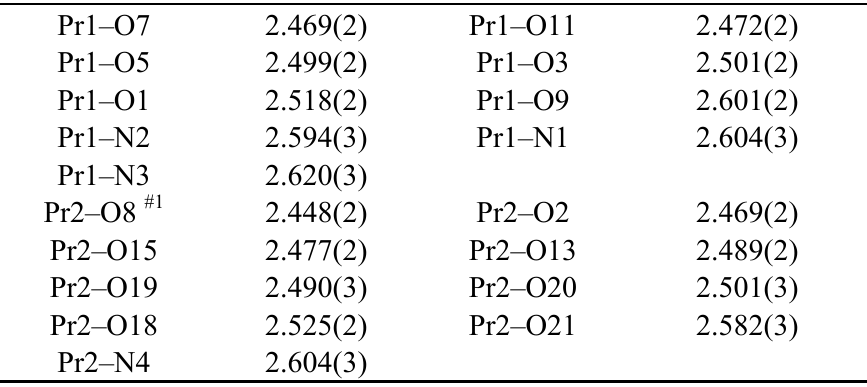
Table 1. Selected bond-distances (Å) in 1 .